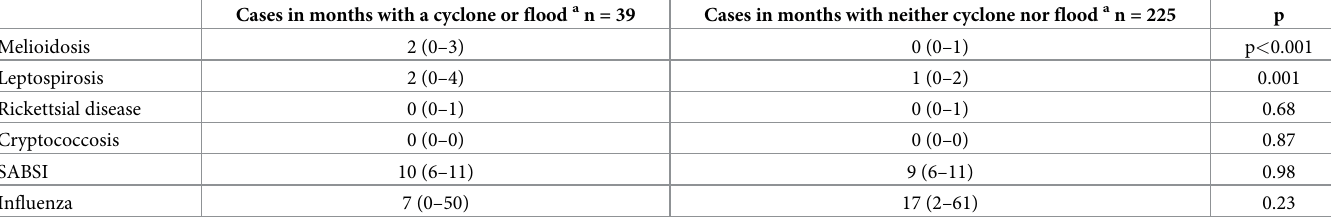
Table 3. Infection numbers associated with severe weather events, in Far North Queensland,